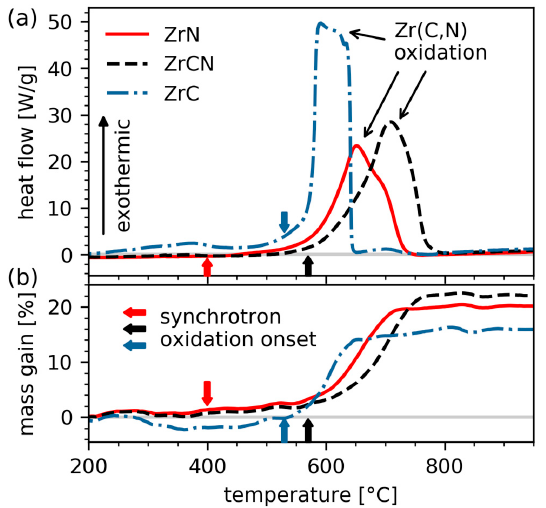
Figure 6. ( a ) Heat flow of the Zr(C,N) samples and ( b ) mass gain from the thermogravimetric analysis as a function of the oxidation temperature. The arrows indicate the oxidation onset temperatures as determined by the in-situ synchrotron powder diffraction